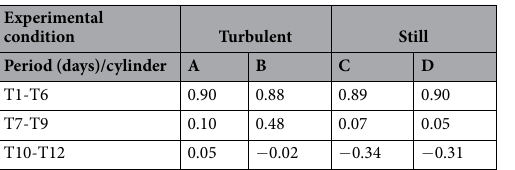
turbulence-exposed and control cultures (Fig. 2c). At T8 the phosphate consumption diverged between still and turbulent conditions, with turbulence-exposed cultures taking up more phosphate than the control ( p -value 0.02,